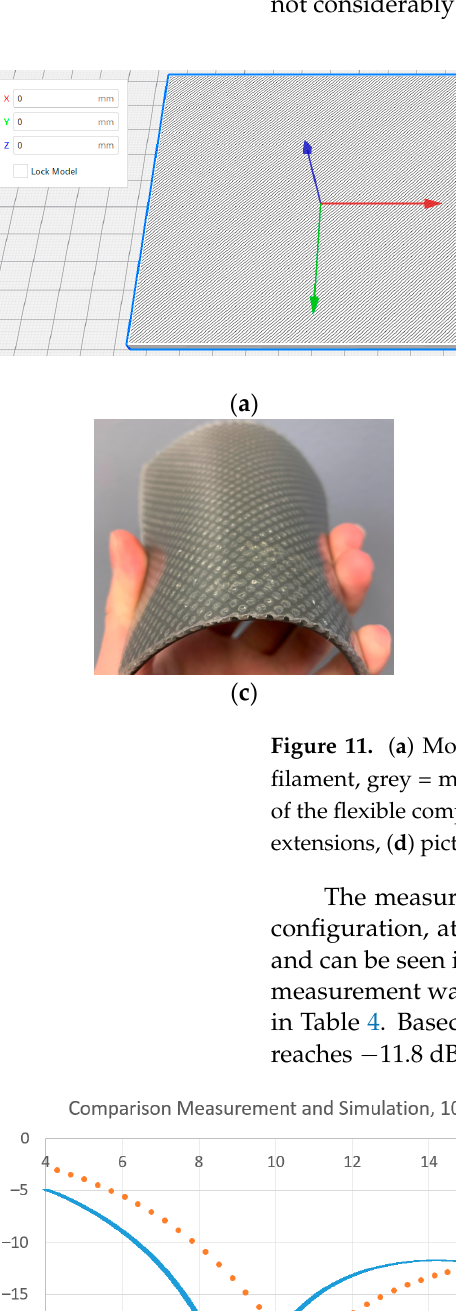
Figure 11 . ( a ) Model of the multilayer structure sliced in Ultimaker Cura (white = non-loaded fila- ment, grey = magnetic loaded filament, red axis = X, green axis = Y, blue axis = Z), ( b ) picture of the flexible composite filament, ( c ) picture of multilayer EM absorber after printing and without exten- sions, ( d ) picture of the multilayer on the side .